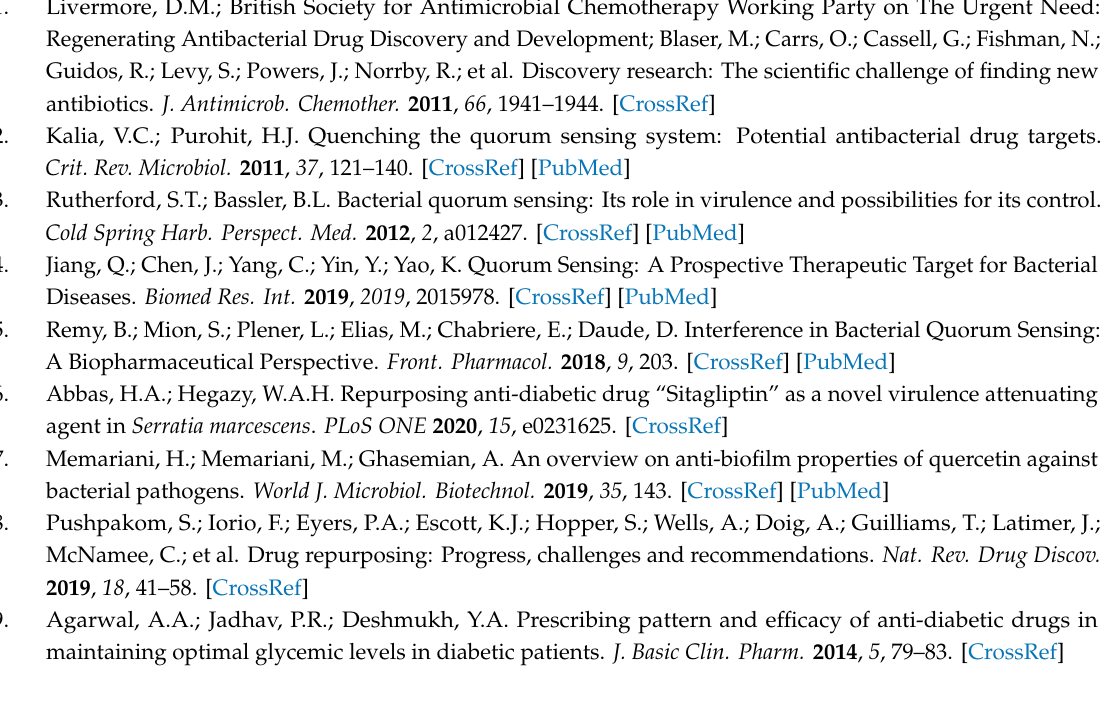
Figure S1: Docking study of tested anti-diabetic drugs into P. aeruginosa QS receptors QscR and